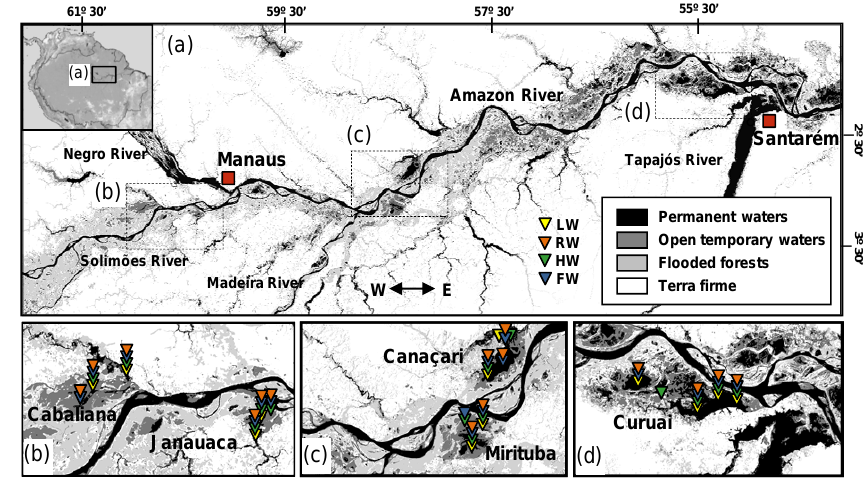
Figure 1. Study area of the central Amazon basin (a) showing five floodplain lakes (várzeas) in panels (b, c, d) . Table 1. Localization and summary of geomorphology, biogeography, and water physicochemical of the five floodplain lakes. Data of temperature, conductivity and pH represent the maximum and minimum values measured in situ for four hydrological seasons. Cabaliana Janauaca Mirituba Canaçari